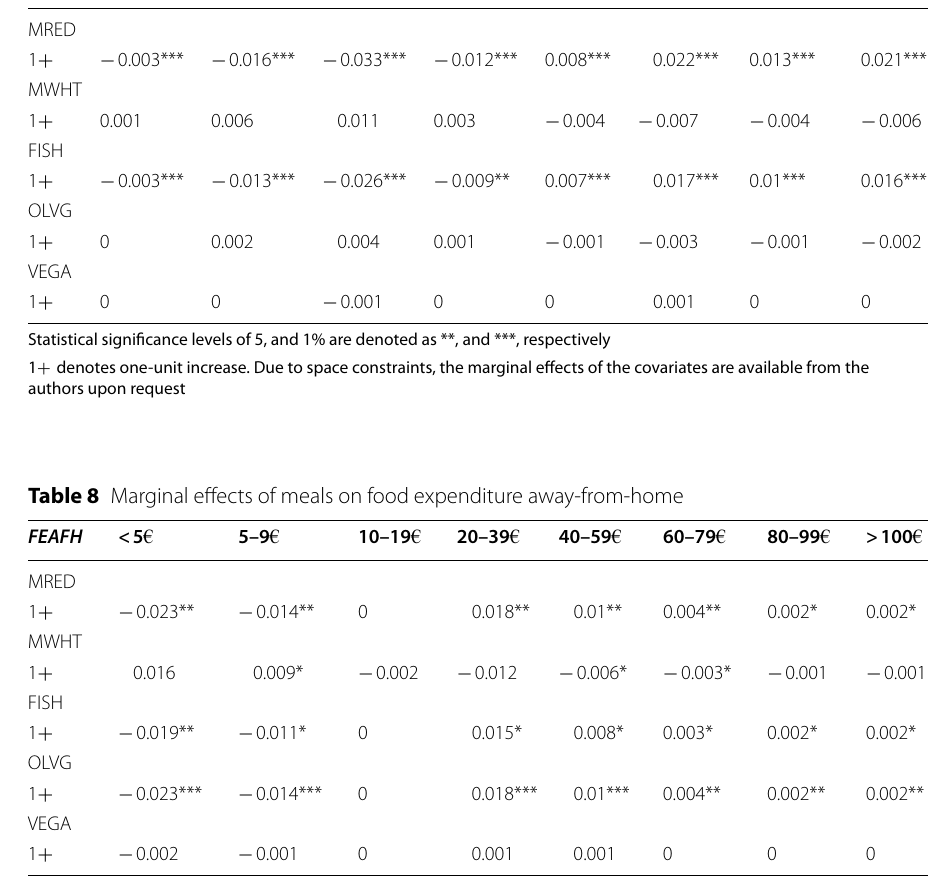
Statistical significance levels of 10, 5, and 1% are denoted as *, **, and ***, respectively 1 denotes one‑unit increase. Due to space constraints, the marginal effects of the covariates are available from the authors + upon request